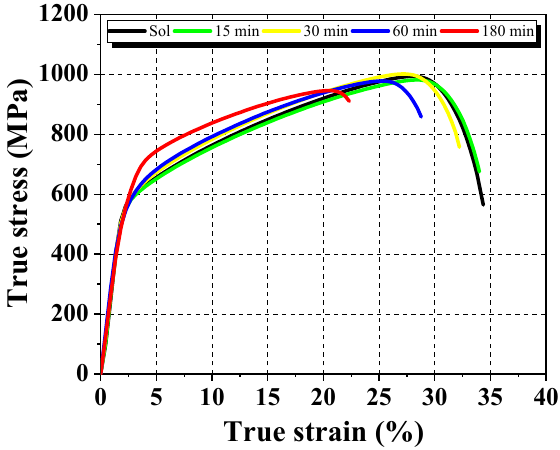
Figure 4. True stress versus true strain behavior as a function of aging time at 800 °C. Table 2. Summary of mechanical properties.